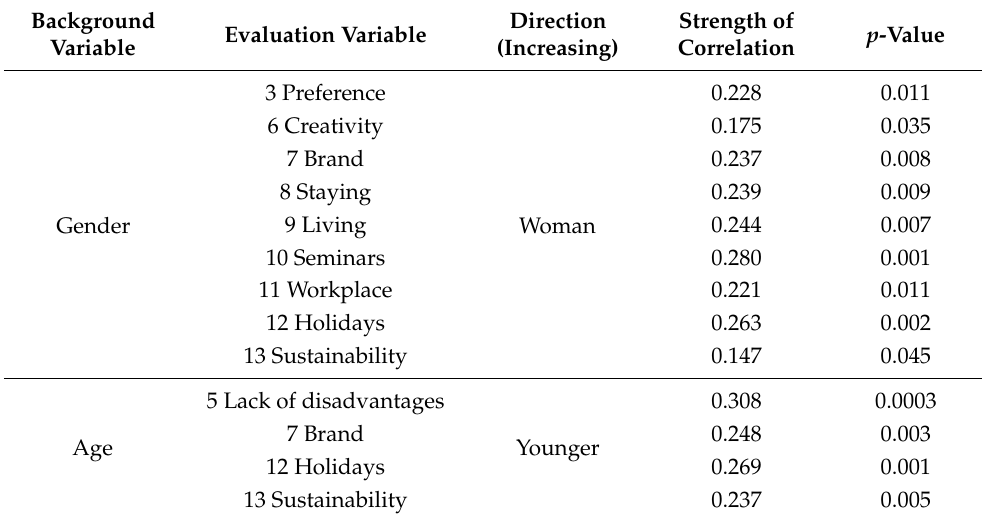
Table 4. Number of answers for each variable of the perception questionnaire reported along with percentages and